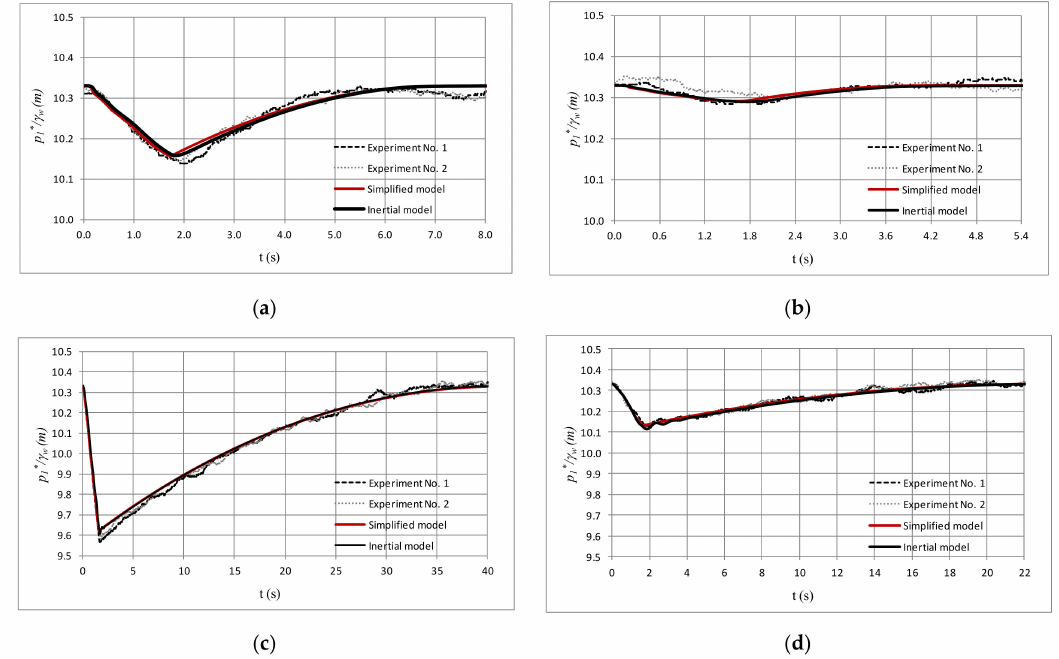
Figure 6. Analysis of calculated air pocket pressure between simplified mathematical model and inertial model, ( a ) Run No. 1; ( b ) Run No. 5; ( c ) Run No. 6; ( d ) Run No.